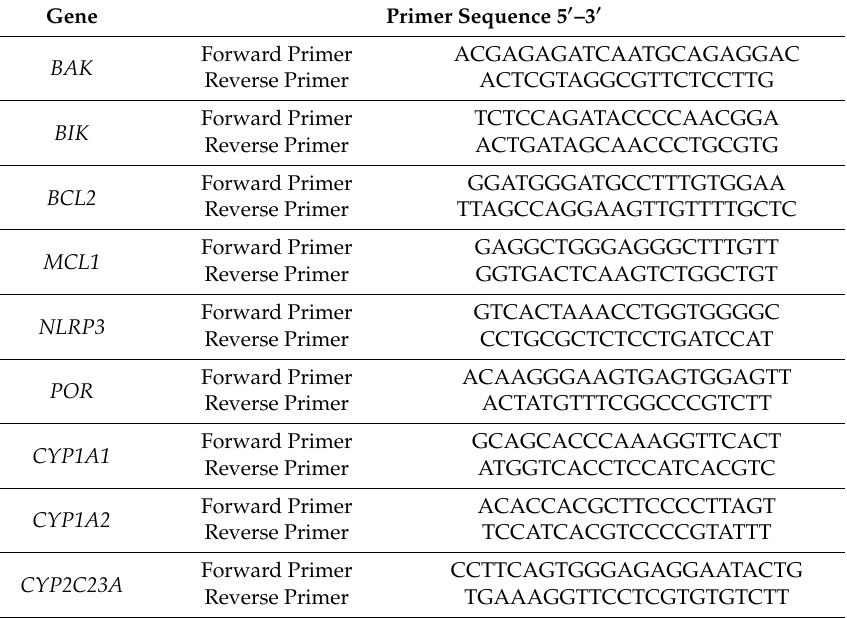
Table 3. Forward and reverse primer sequences for each gene used for real-time quantitative Polymerase Chain Reaction